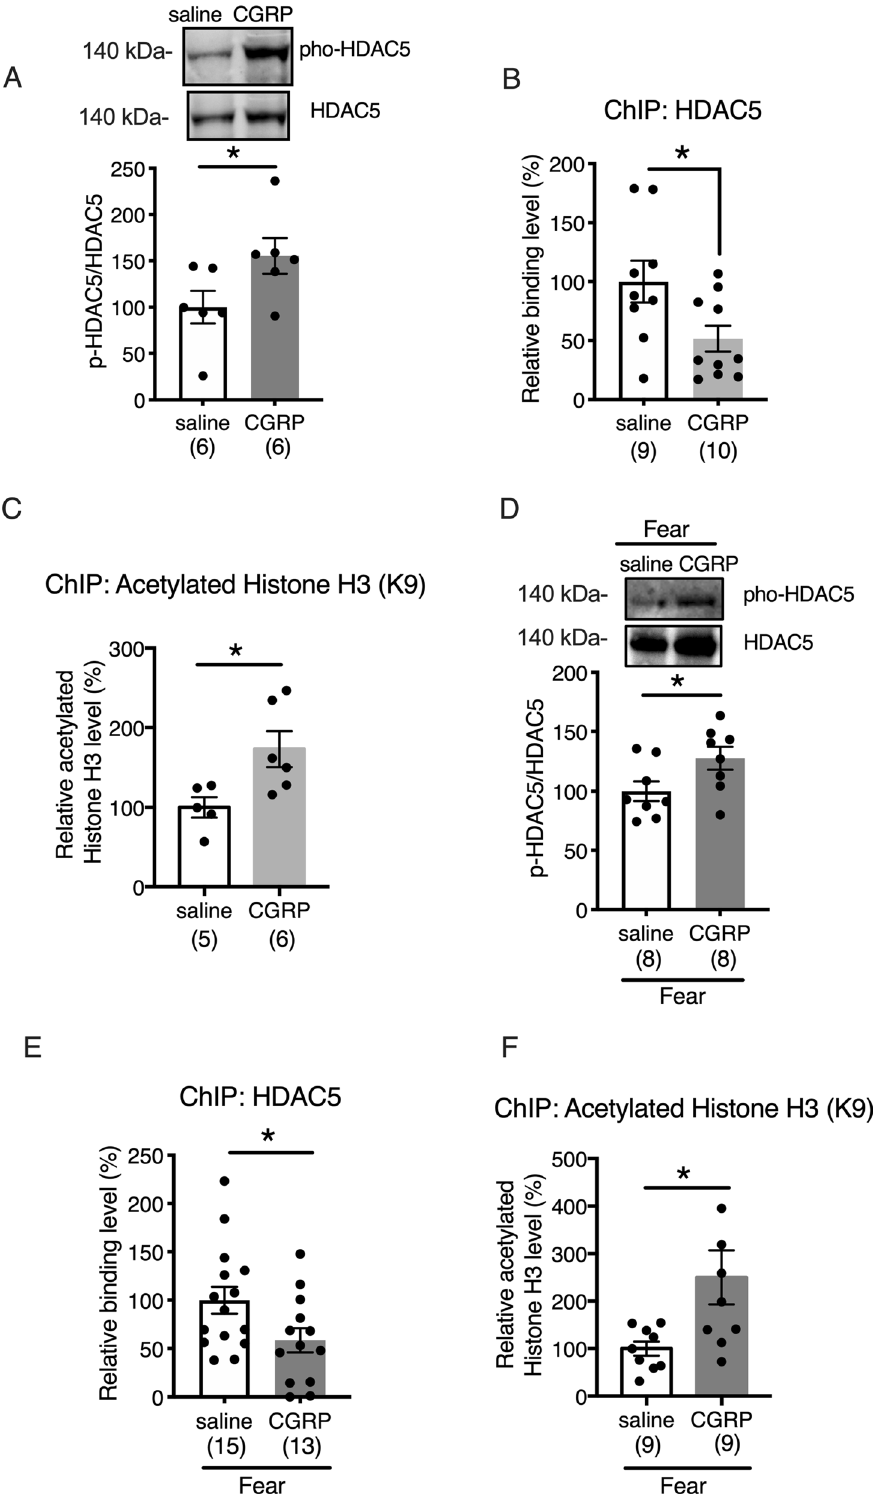
Figure 3. HDAC5 and histone H3 acetylation are involved in the CGRP-mediated suppression of fear memory retention. ( A ) Phosphorylated HDAC5 expression (Welch’s t test, p = 0.0298). ( B ) Chromatin, obtained from the mouse hippocampus, was immunoprecipitated using antibodies against HDAC5 (Welch’s t test, p = 0.0181) ( B ), histone H3, and acetylated histone H3 (K9) ( C ) (Welch’s t test, p = 0.0116). After immunoprecipitation, Npas4 enhancer expression was evaluated by qt-PCR. ( D ) Phosphorylated HDAC5 expression after fear conditioning (Welch’s t test, p = 0.0241). ( E ) Chromatin, obtained from the mouse hippocampus after fear conditioning, was immunoprecipitated using antibodies against HDAC5 (Welch’s t test, p = 0.0182) ( E ), histone H3, and acetylated histone H3 (K9) ( F ) (Welch’s t test, p = 0.0156). Each bar indicates the mean ± S.E.M. Student’s t-test * p < 0.05. Numbers in parentheses indicate the number of animals in each group. The full-length blots are presented in Supplementary Fig.